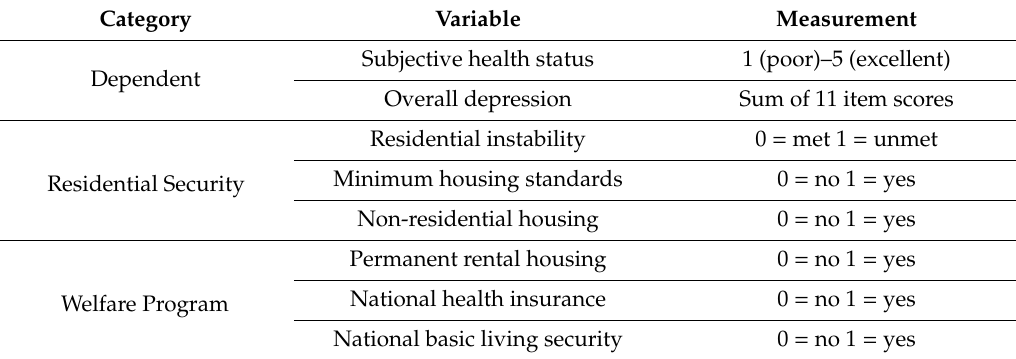
Table 2. Variable